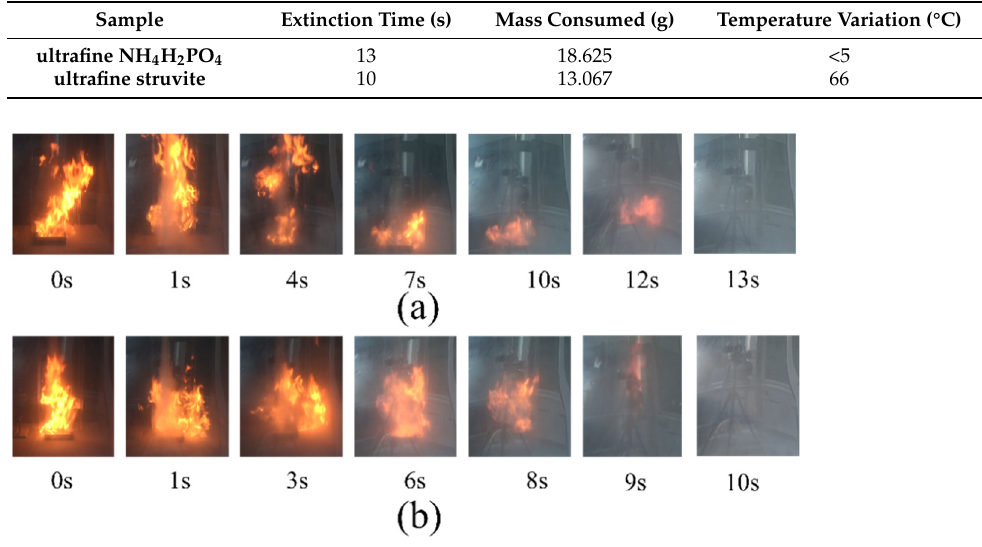
Figure 6. Images of the fire suppression processes of the tests with different samples at 0.2 MPa. ( a ) ultrafine NH 4 H 2 PO 4 powder and ( b ) ultrafine struvite ultrafine NH 4 H 2 PO 4 powder and ( b ) ultrafine struvite powder.